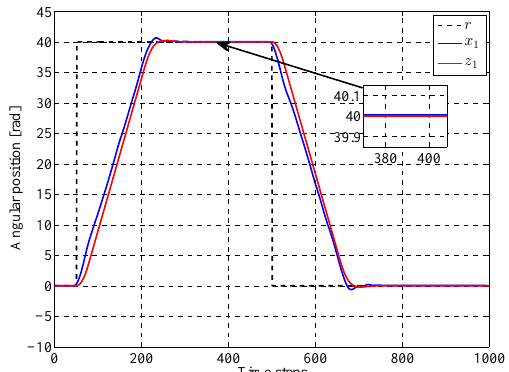
Figure 13: Chattering free SMC component of the pro- posed